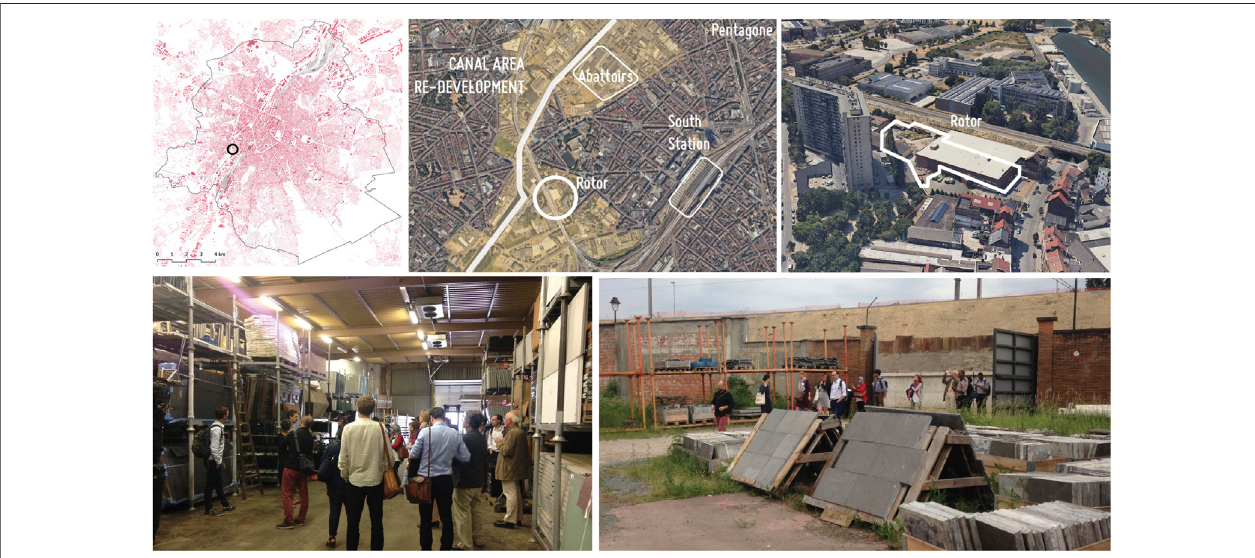
FIGURE 6 | Location in the BCR, aerial views from Google Maps, photos of the courtyard and storage. Collage by the authors.